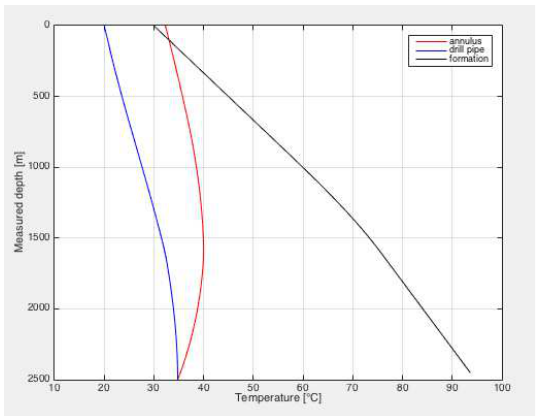
Figure 9: Temperature distribution( k f = 0 . 4 W/m ◦ C)